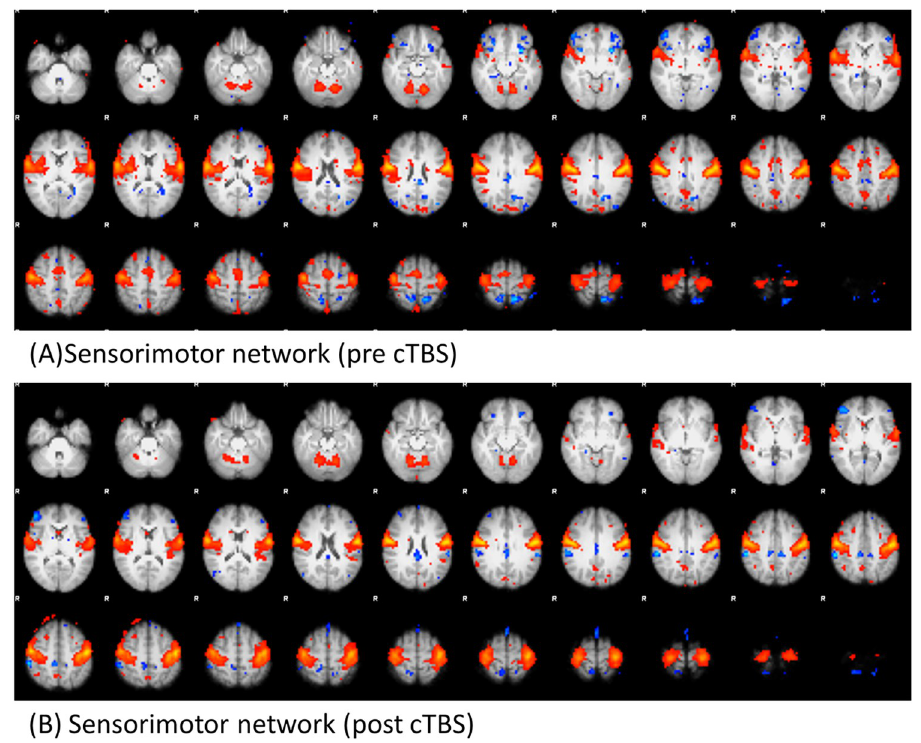
Fig 5. Visualization of the primary motor network analyzed using FSL MELODIC. A) Pre-cTBS primary motor network. B) Post-cTBS primary motor network.